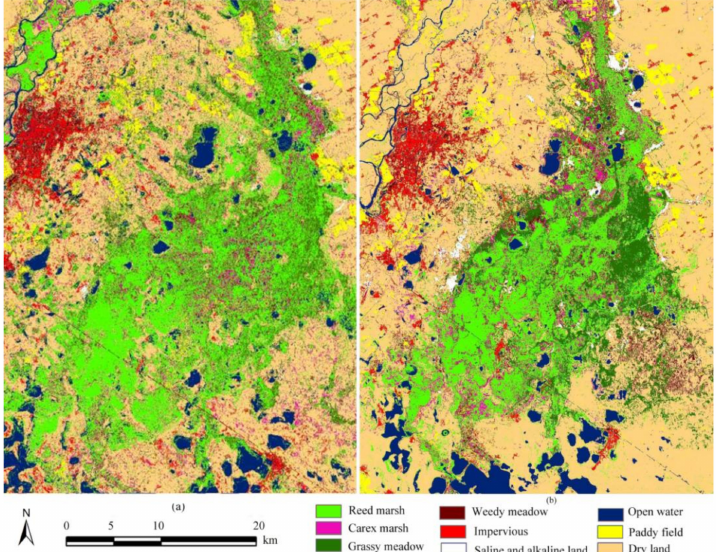
Figure 5. Comparison between the referenced abundances and the modeled abundances derived from the sparse constrained least squares linear spectral mixture model (SCLS-LSMM) for ( a ) Reed marsh, ( b ), Carex marsh, ( c ) Grassy meadow and ( d ) Weedy